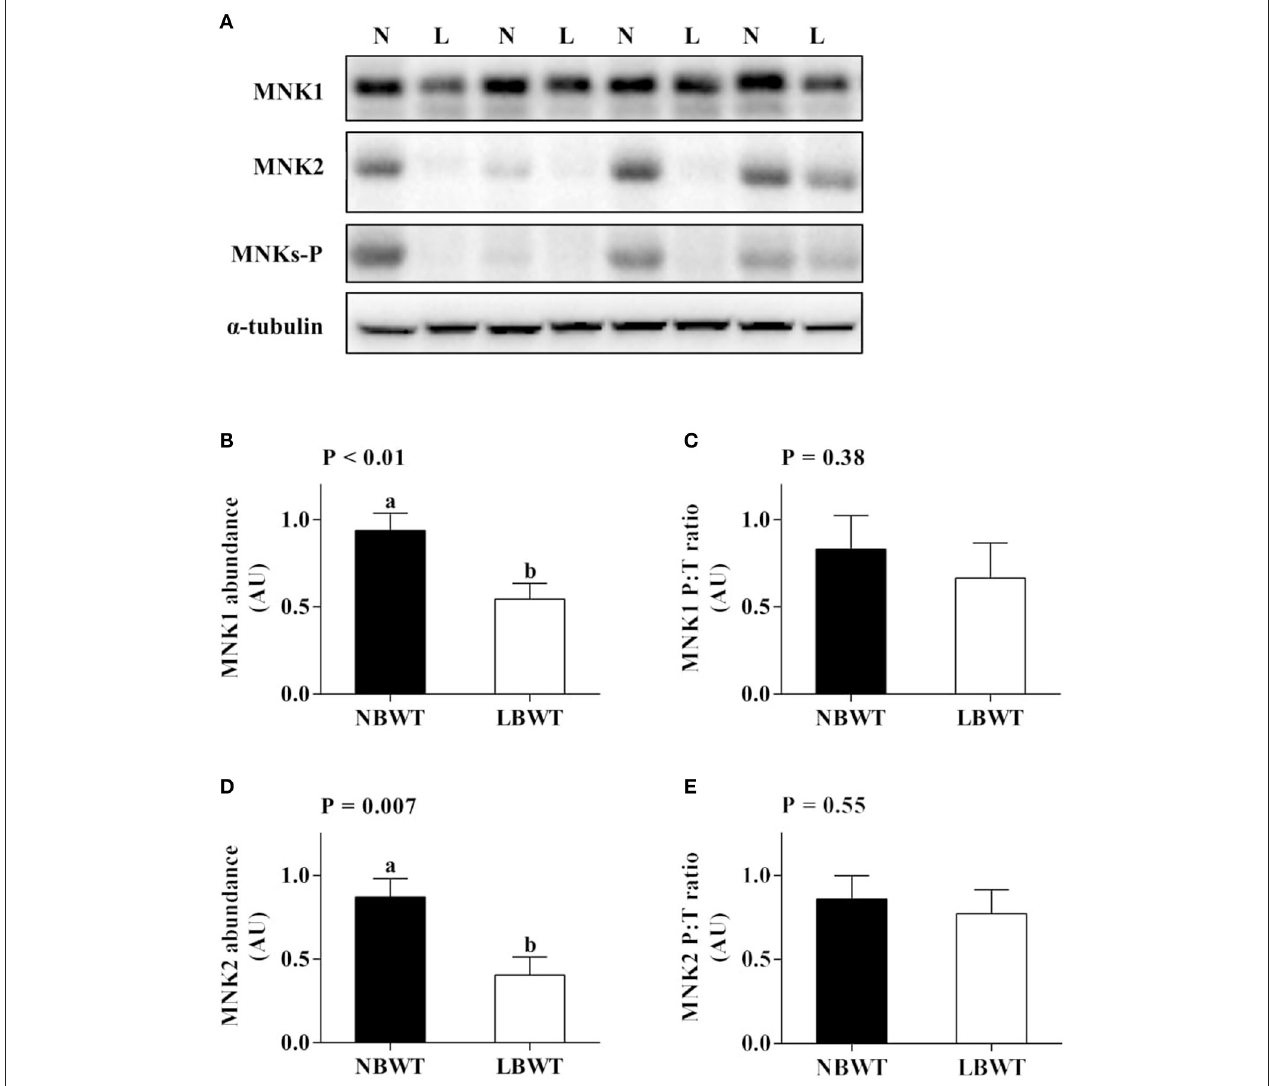
FIGURE 7 | Protein abundance and phosphorylation of MNK1/2 in longissimus dorsi muscle of low-birth-weight (LBWT) and normal-birth-weight (NBWT) neonatal pigs. (A) : Representative western blots from four pairs of LBWT and NBWT pigs (N, NBWT; L, LBWT). (B – E) : Protein abundance and phosphorylation of MNK1 and MNK2. Abundance was normalized to α -tubulin and phosphorylation normalized to the corresponding non-phospho-proteins. Results are means ± SE. n = 12. Values with different letters differ significantly ( P ≤